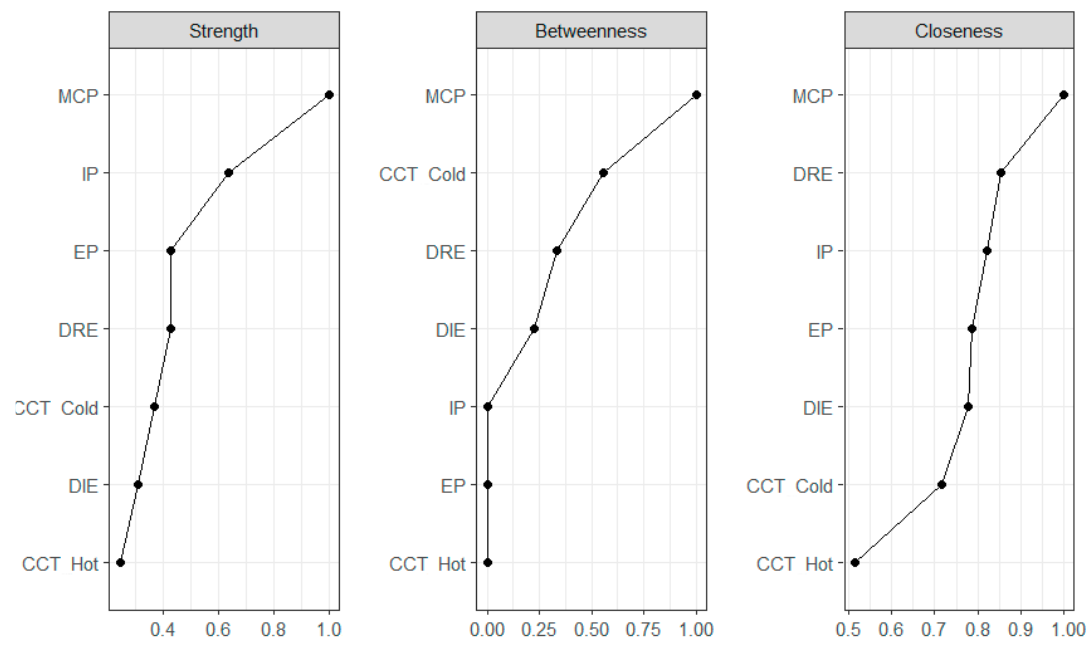
Figure 6. Node strength, betweenness, and closeness centrality estimates for three Youth Self-Report (YSR) indexes, two Difficulties in Emotion Regulation Strategies (DERS) indexes, and risk propensity in decision-making tasks.